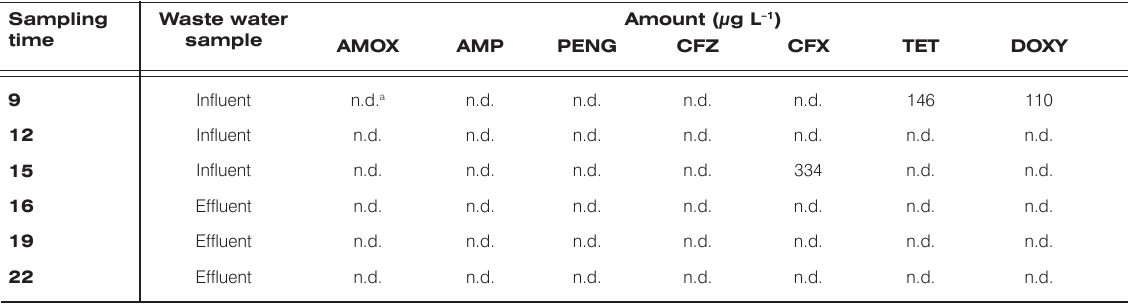
Table 7. Amount of the studied antibiotics in waste water samples collected in the same day at intervals of three hours from influents and effluents of WWTP respectively. Sampling